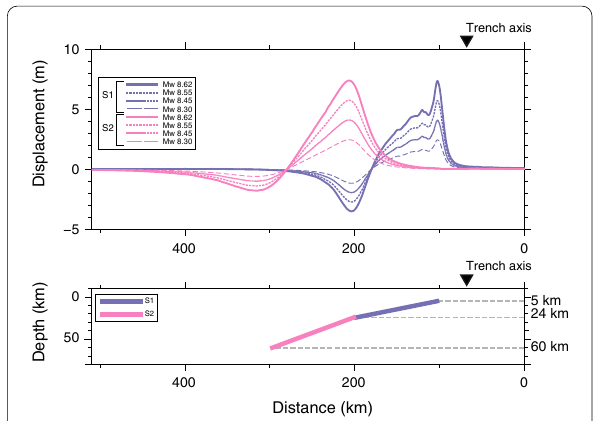
Fig. 5 Cross section of earthquake mechanism of the S1 and S2 models. The upper figure shows the initial crustal deformation of each case. The lower one depicts the vertical cross section of the fault plane (S1 and S2 models)